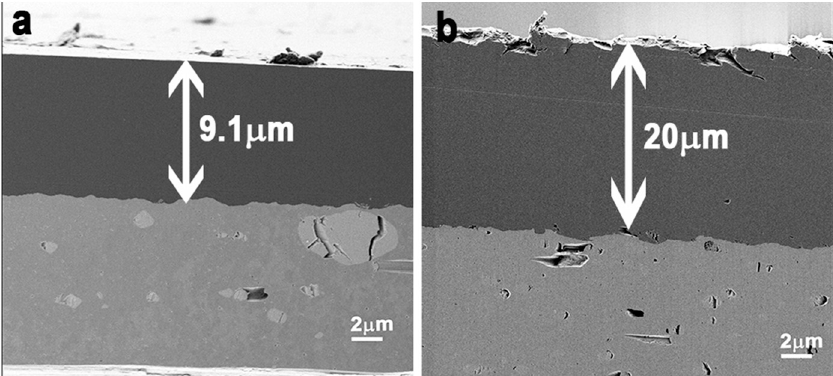
Figure 4. SEM micrographs of the cross sections of the alloy surface and its coatings: ( a ) AA- poly(methyl methacrylate) (PMMA) 90 ′ and ( b ) AA-TE-PMMA 90 ′ .